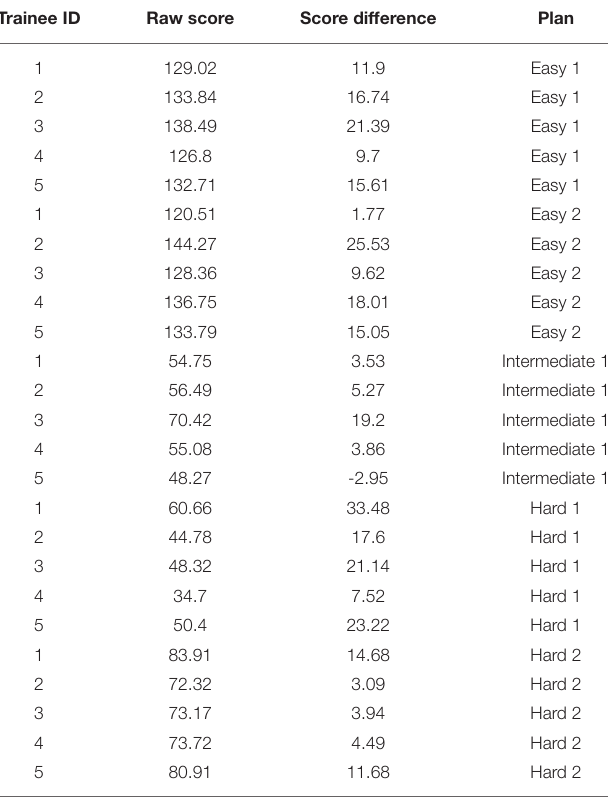
TABLE 3 | Scores of five plans during training for each of five trainees. Score difference is defined as the difference between trainee’s plan’s score vs. the clinical plan’s score.